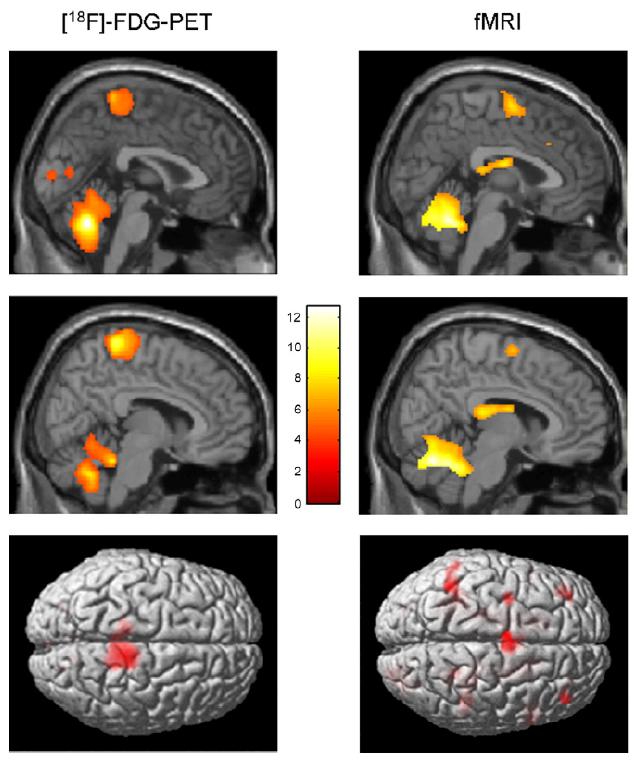
Figure 6. Comparison of real (PET) and imagined locomotion (fMRI) brain activations (this figure is reproduced with permission from [105]; Copyright Elsevier, 2010). Sagittal midline and render views are